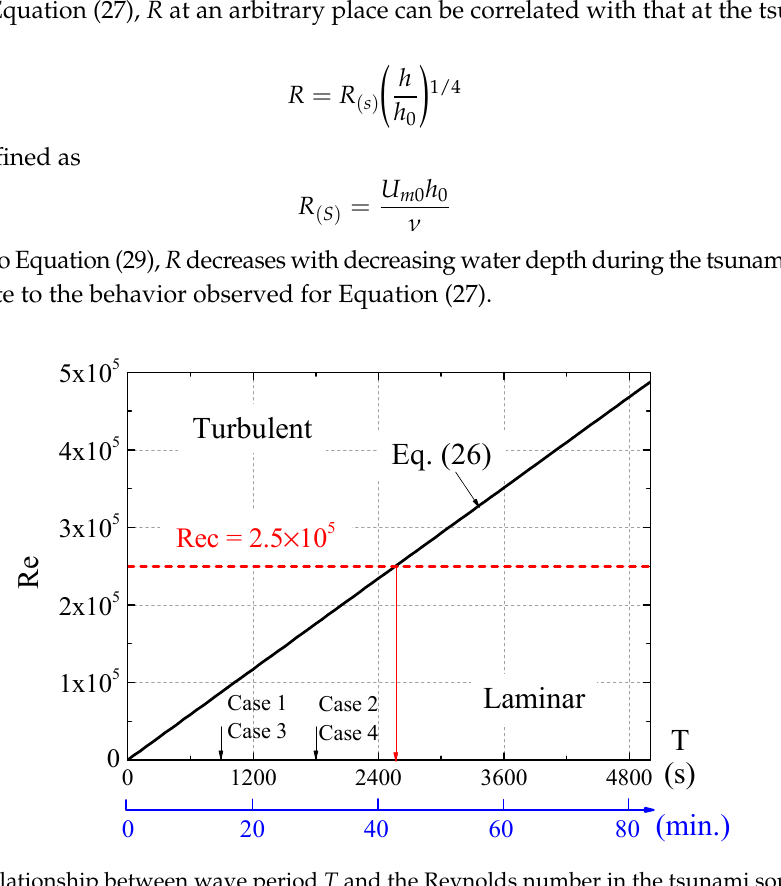
Figure 5. Relationship between wave period T and the Reynolds number in the tsunami source area.